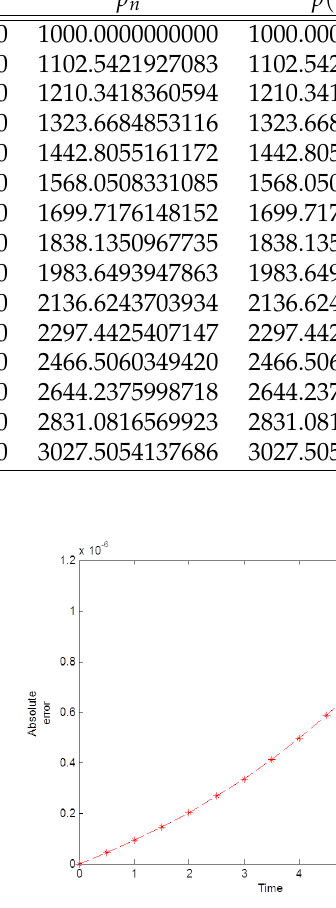
Figure 3. Errors generated via the scheme